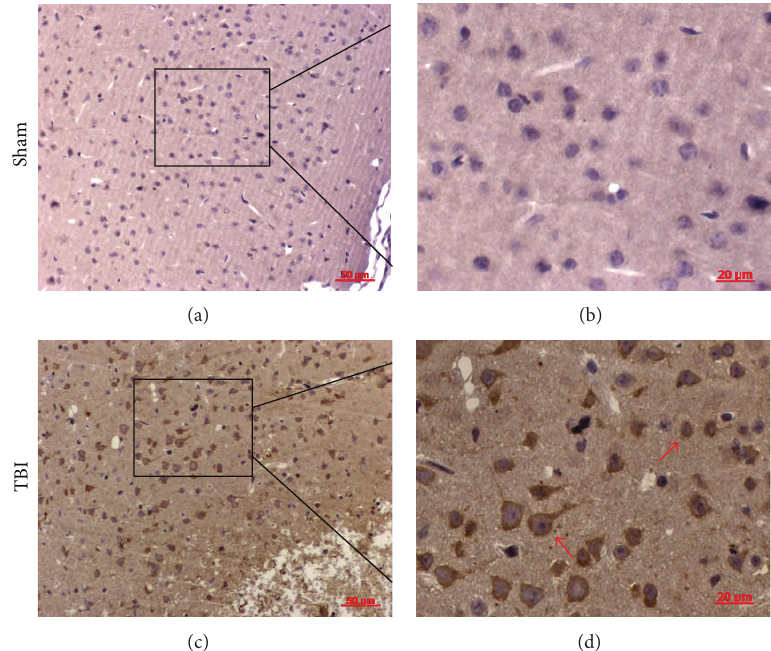
Figure 3: Representative photomicrographs showing cathepsin S (CatS) immunohistochemistry of tissue from the sham and traumatic brain injury (TBI) groups. In the sham group, almost none of the cells presented a positive morphology, whereas, in the TBI group, many cells were positive for CatS. CatS was present mainly in the cytoplasm. The CatS-positive cells in the TBI group (indicated by arrows) showed two populations of cells with different